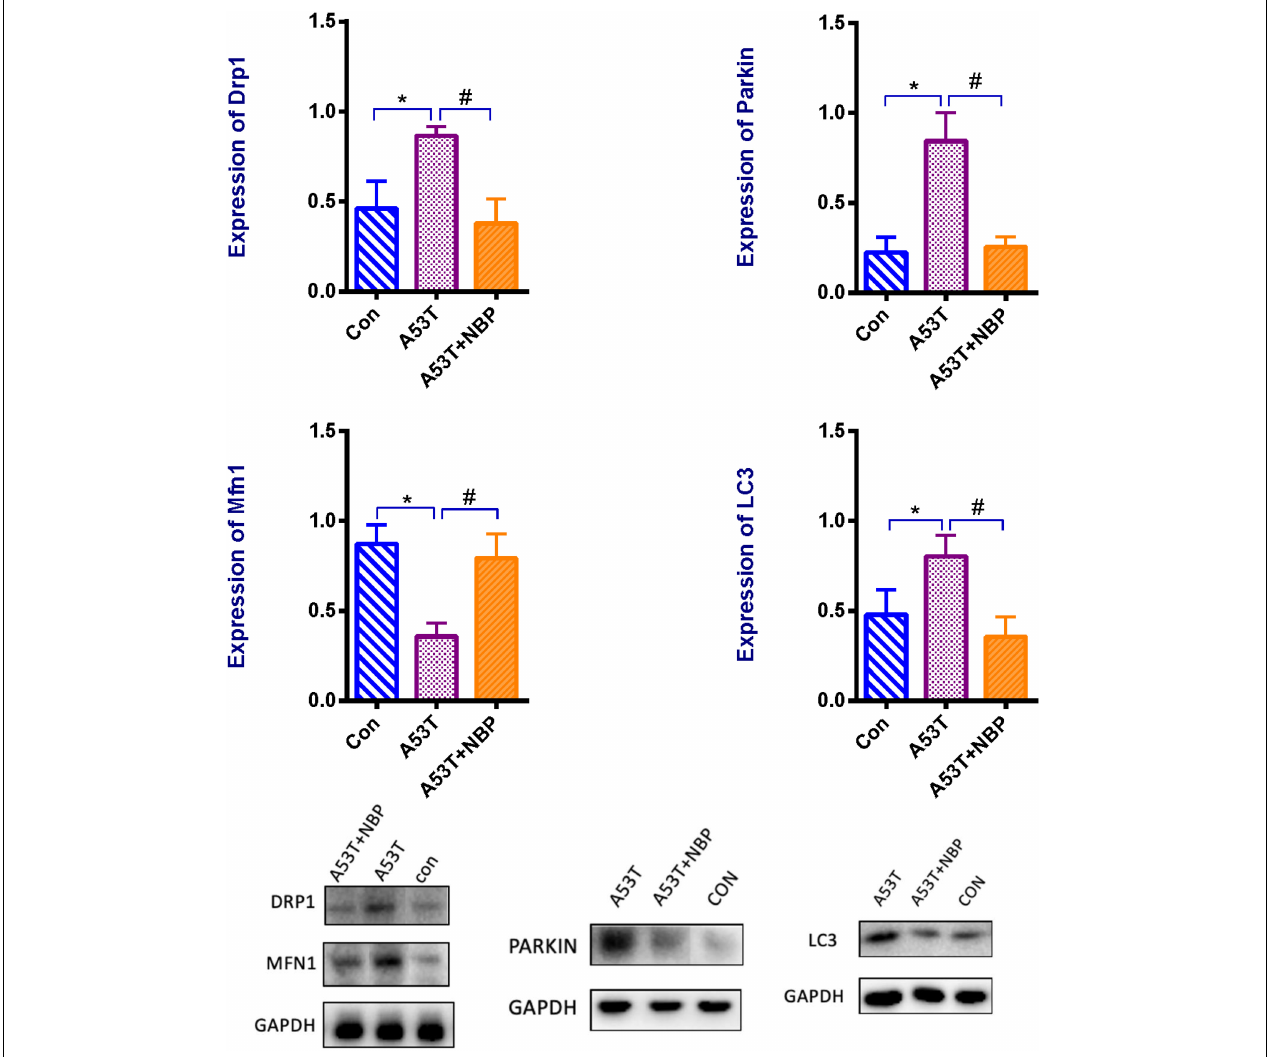
FIGURE 4 | Mitochondrial proteins, autophagy, and mitophagy. Western blotting assay for the protein level of dynamin-related protein 1 (Drp1), and mitofusin 1 (Mfn1), Parkin, and LC3. When quantified, the expression of Drp1 was higher, and Mfn1 level was lower in the A53T group than that in the control group. Meanwhile, LC3 and Parkin levels were higher significantly. After 2-week NBP treatment, the results were all reversed significantly. All data were expressed as mean ± SD. * P < 0.05 and # P < 0.05.